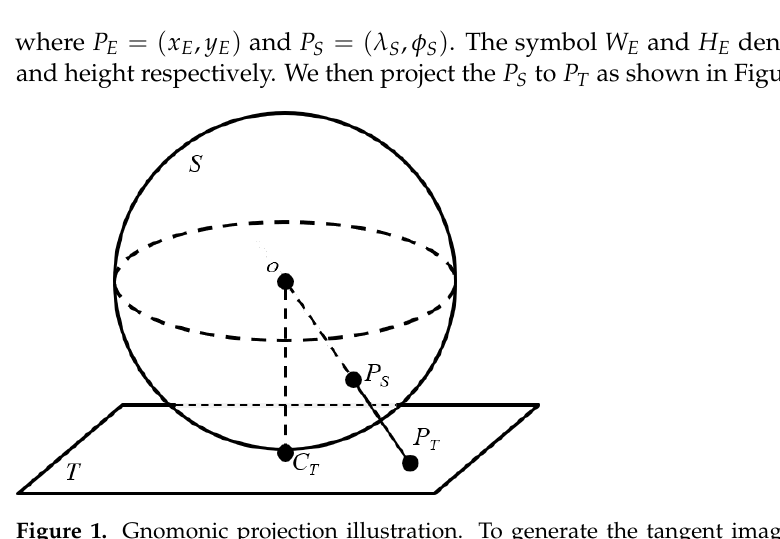
Figure 1. Gnomonic projection illustration. To generate the tangent image (TI) T , we find the correspondence of every TI pixel P T on the sphere: P S . The resulting P S is different for every possible TI T . Each TI T coincide with sphere S on C T . We set C T to be in the center of TI T